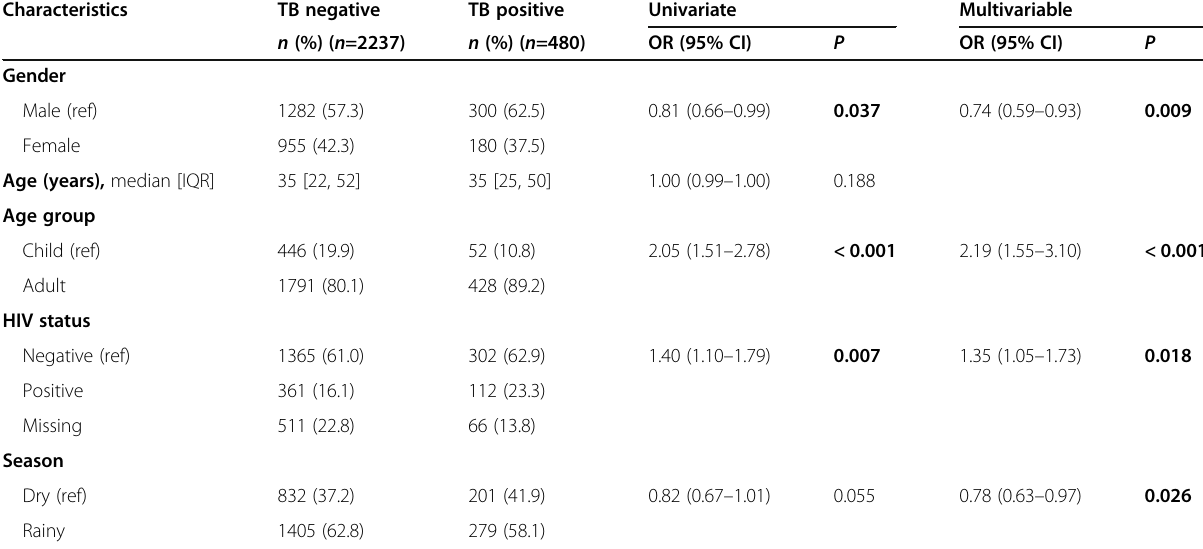
Table 4 Comparison of TB negative and TB positive characteristics